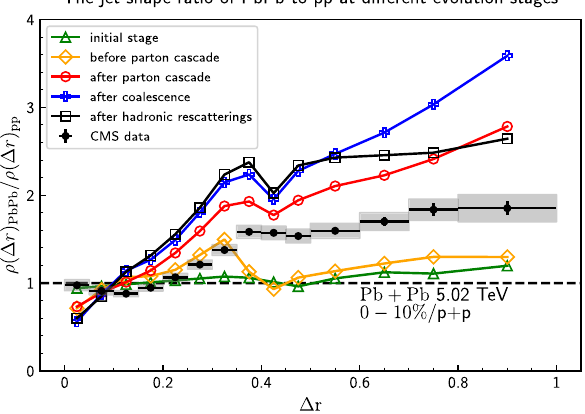
Fig. 9 The ratio of jet shape function ρ((cid:2) r ) in Pb + Pb collisions to that in p + p collisions for different scenarios: initial stage, before par- ton cascade, after parton cascade, after coalescence, and after hadronic rescatterings. The data are taken from CMS